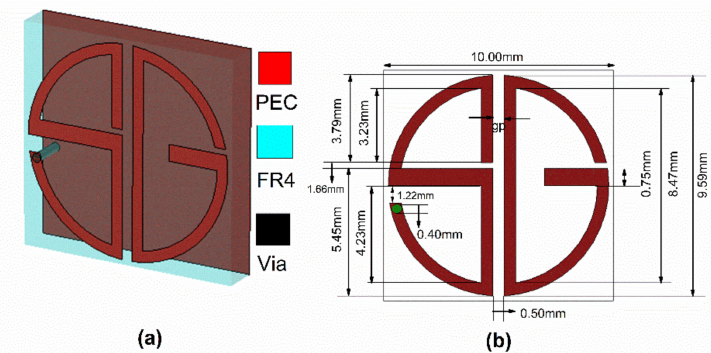
Figure 1. ( a ) Perspective view of the Unit cell; ( b ) Unit cell